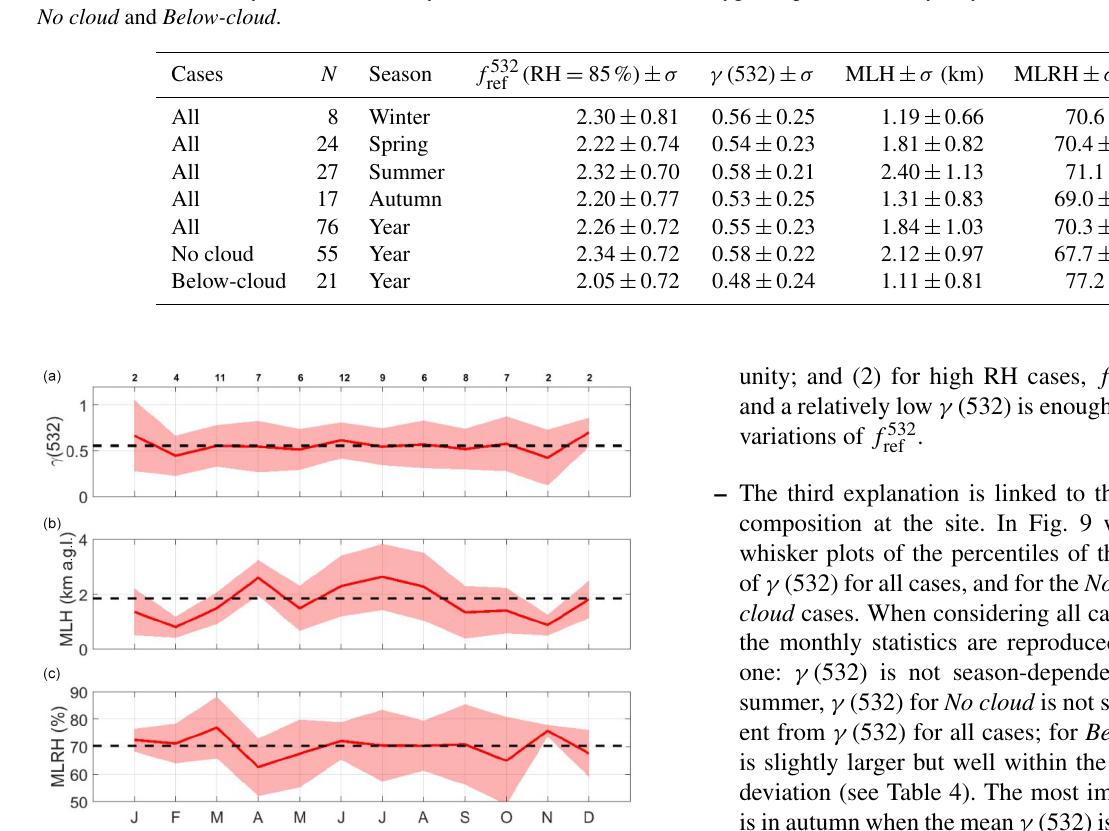
at RH = 85% and RH ref = 40%, γ (532), the mean layer height ref